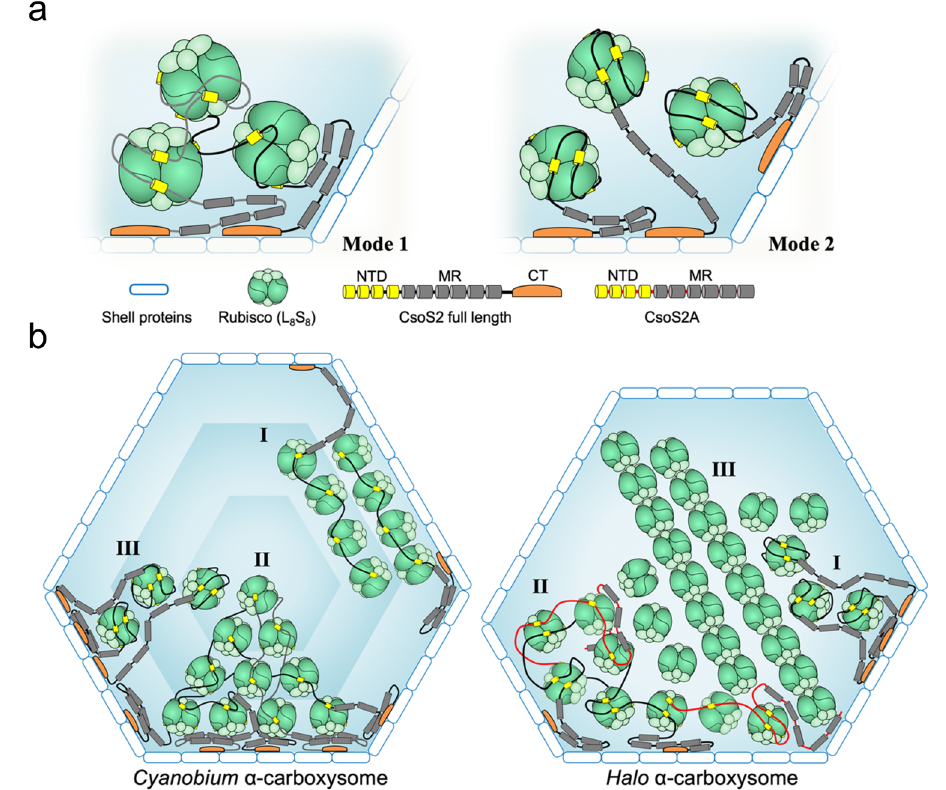
Fig. 4 | Models of CsoS2-mediated Rubisco assembly within α -carboxysomes. a ModelsofCsoS2andRubiscointeractionwithin α -carboxysomes.Therecouldbe a crosslinking assembly: each N-Terminal Domain (NTD) of CsoS2 interacts with multiple Rubiscos (up to four), and eachRubisco bindsmultipleCsoS2(left,